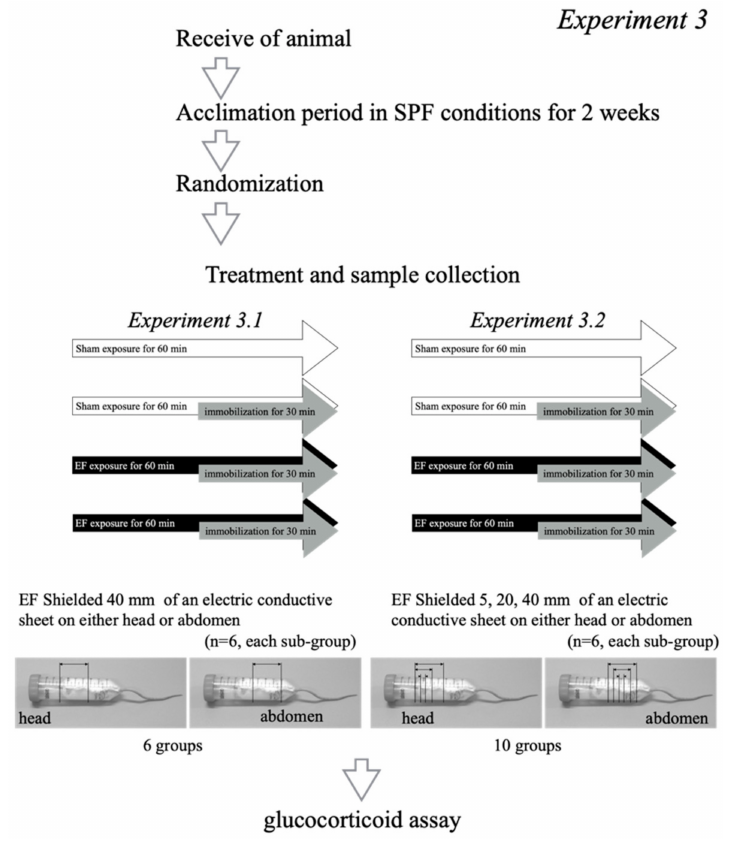
Figure 4. Experimental design to assess the effect of EF shield on the suppressive effect of EF, Experiment 3. To examine the effect of an EF shield on the suppressive effect of an EF on plasma GC, 96 mice were divided into 36 mice (6 groups) and 60 mice (10 groups). Thirty-six mice were divided into 6 groups ( n = 6 each group): control (stress ( − )/EF ( − )), EF-alone (stress ( − )/EF (+)), immobilization-alone (stress (+)/EF ( − )), co-treatment (stress (+)/EF (+)), and co-treatment with shielding at the head, or at the abdomen, using a 40 mm–long shield sheet (stress (+)/EF (+)/shielded) (Figure 4). Subsequently, 60 mice were divided into 10 groups ( n = 6 each group): control (stress ( − )/EF ( − )), EF-alone (stress ( − )/EF (+)), immobilization-alone (stress (+)/EF ( − )), co-treatment (stress (+)/EF (+)), and co-treatment with shielding at the head, or at the abdomen, using different length shield sheets (stress (+)/EF (+)/shielded):control (stress ( − )/EF ( − )), EF-alone (stress ( − )/EF (+)), immobilization-alone (stress (+)/EF ( − )), co-treatment (stress (+)/EF (+)), and co-treatment with shielding to the head or the abdomen (stress (+)/EF (+)/shielded (sheet width: 5, 20, or 40 mm on either head or